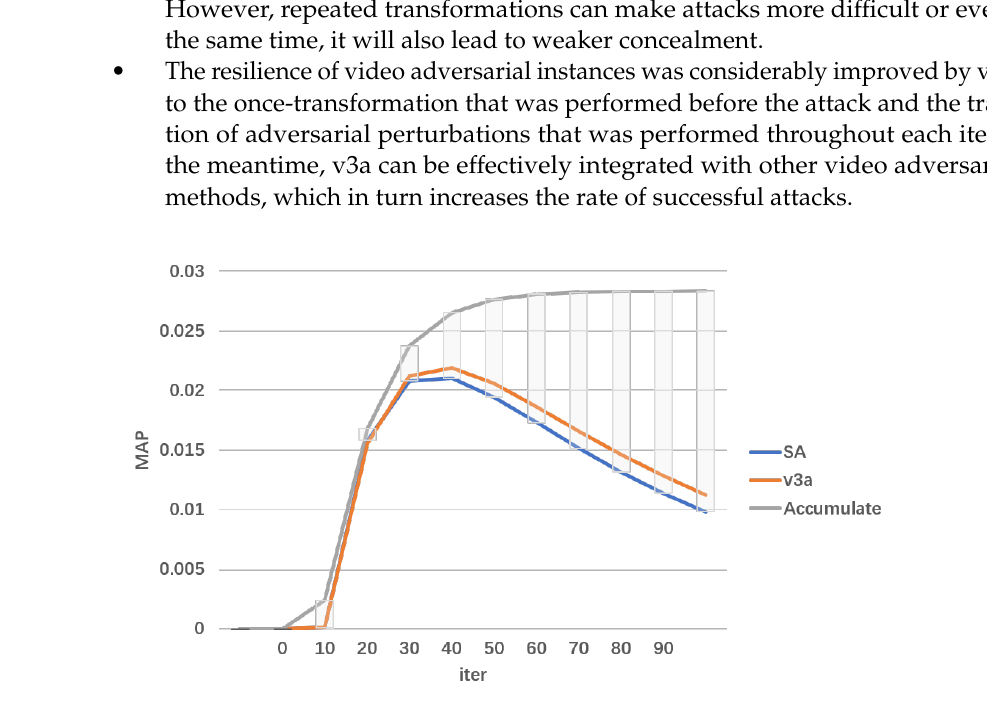
Figure 4. The trend of MAP with iterations on UCF-101 toward the LRCN model.